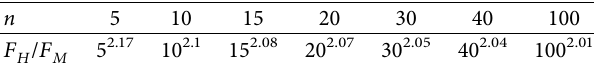
Table 15: Verification of similarity ratio relationship of the pull-out force analysis